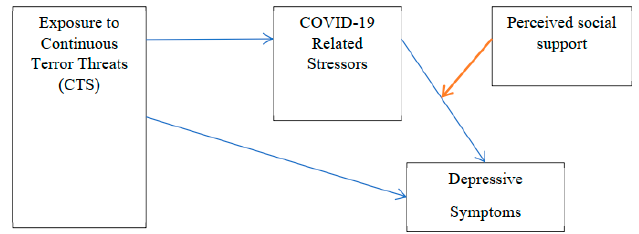
Figure 1. Mediation and Moderation Path